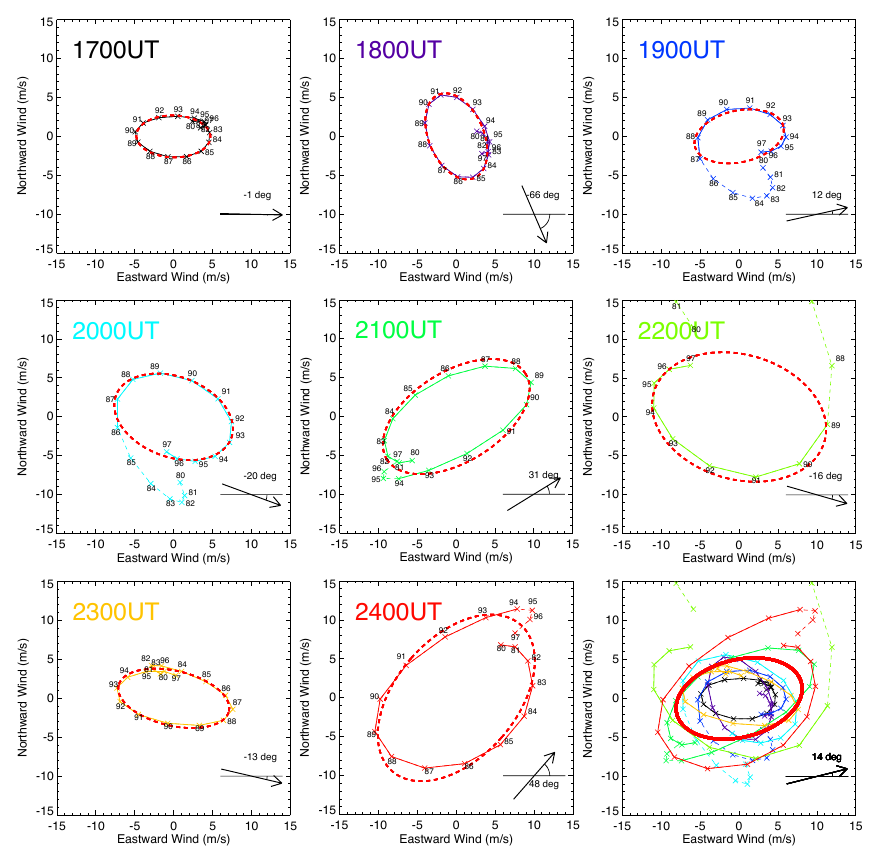
Figure 4. Eight hourly hodographs associated with the fitted eclipses are shown. Crosses denote data values associated with corresponding height values (in km). In the bottom right panel, superimposed hodographs with the fitted ellipse (thicker solid line) are presented. The estimated propagation direction is illustrated in each